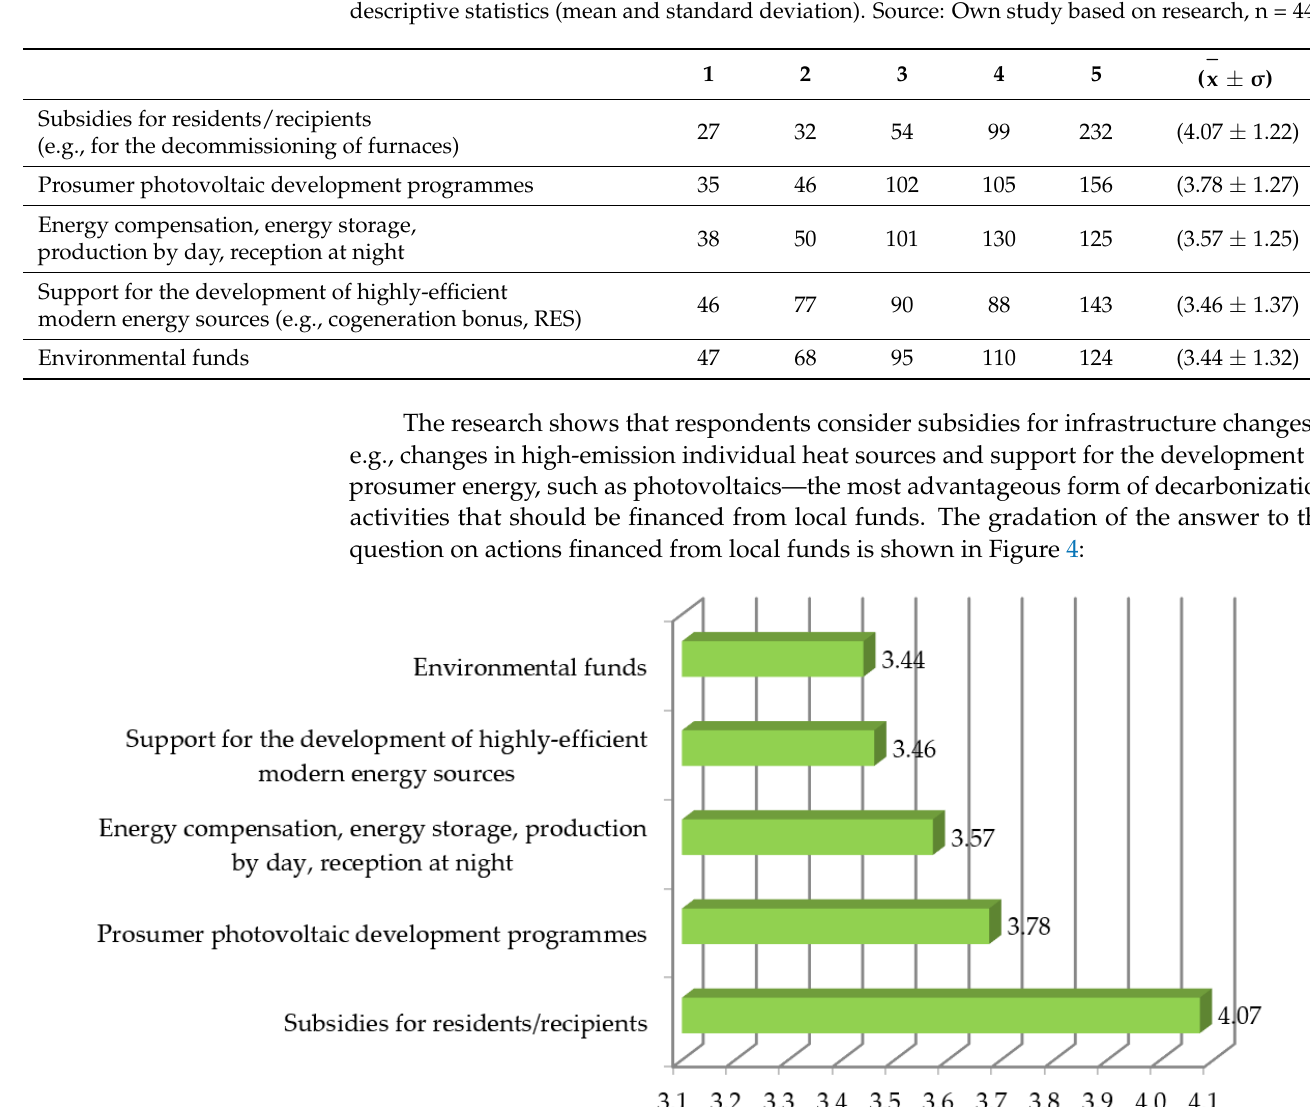
Table 5. Assessment of individual factors and socio-economic characteristics. Source: Own re-